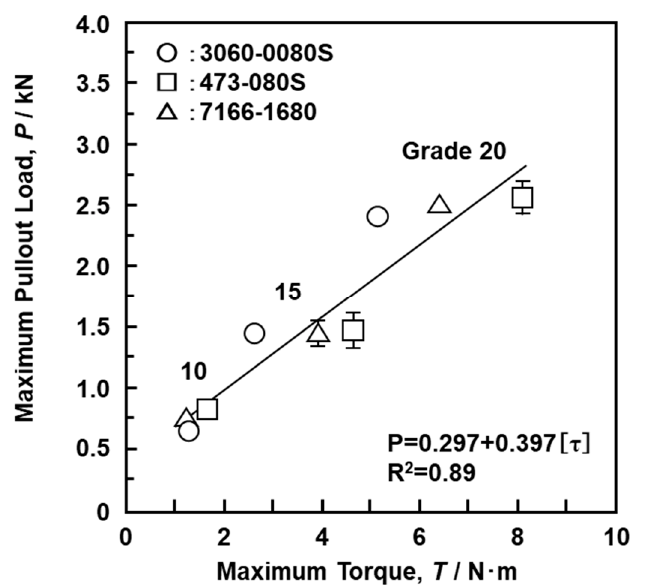
Figure 14. Relationship between maximum pullout load and maximum driving torque with S-bone SRPF obtained using lag screws (80 mm) of short femoral nails.